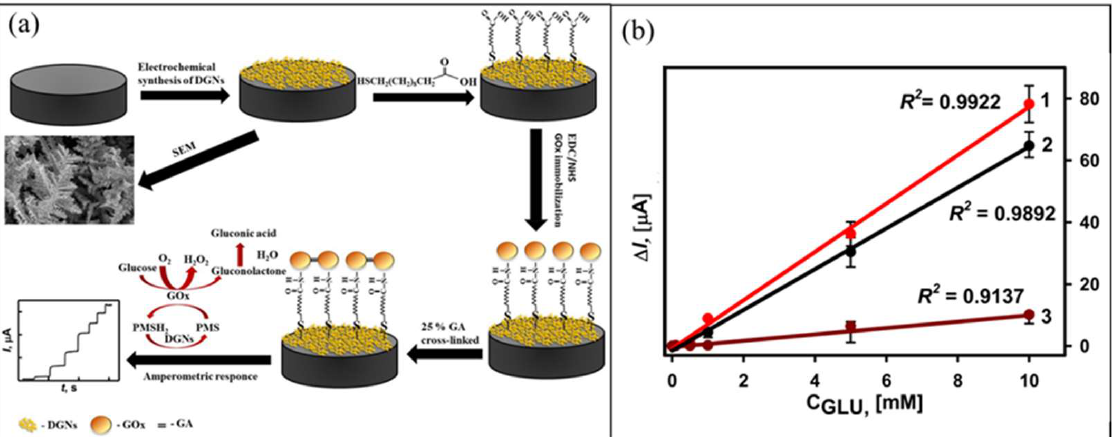
Figure 8. ( a ) Schematic of GOx immobilization by the third method of GA-GOx-SAM/x Au-nanostructure/graphite rod. ( b ) The calibration plot of amperometric response of GA-GOx/dendritic Au-nanostructure/graphite rod (curve 1, third method), GOx-SAM/dendritic Au-nanostructure/graphite rod (curve 2, first method), and GA-GOx-SAM/dendritic Au-nanostructure/graphite rod (curve 3, second method)-modified electrode. Reprinted with permission from ref. [105]; Copyright 2022 MDPI.